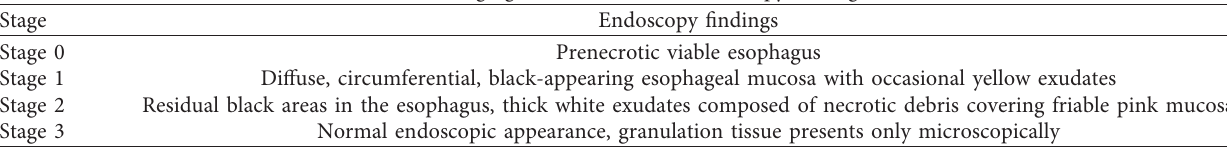
Figure 3: Endoscopic image showing friable esophageal mucosa, mucosal separation without active bleeding. Table 1: Staging of AEN based on endoscopy